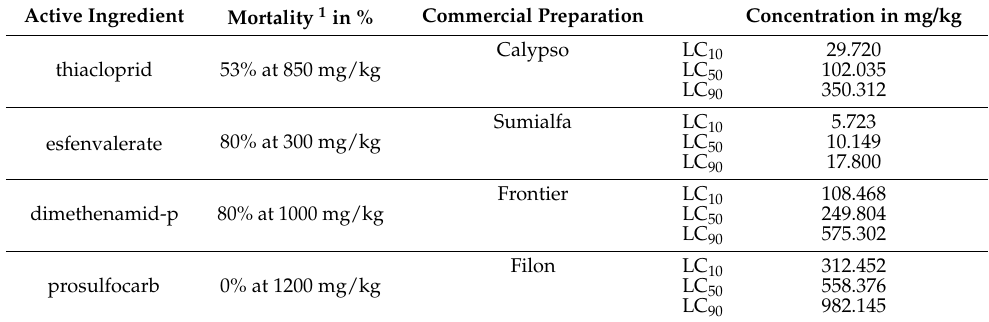
Table 1. Acute toxicity results after 48 h pesticide exposures to E. andrei in soil. Active